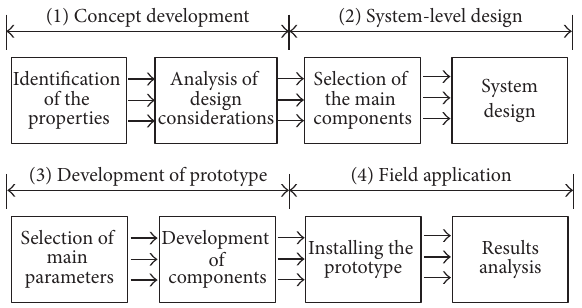
Figure 1: Research scope and